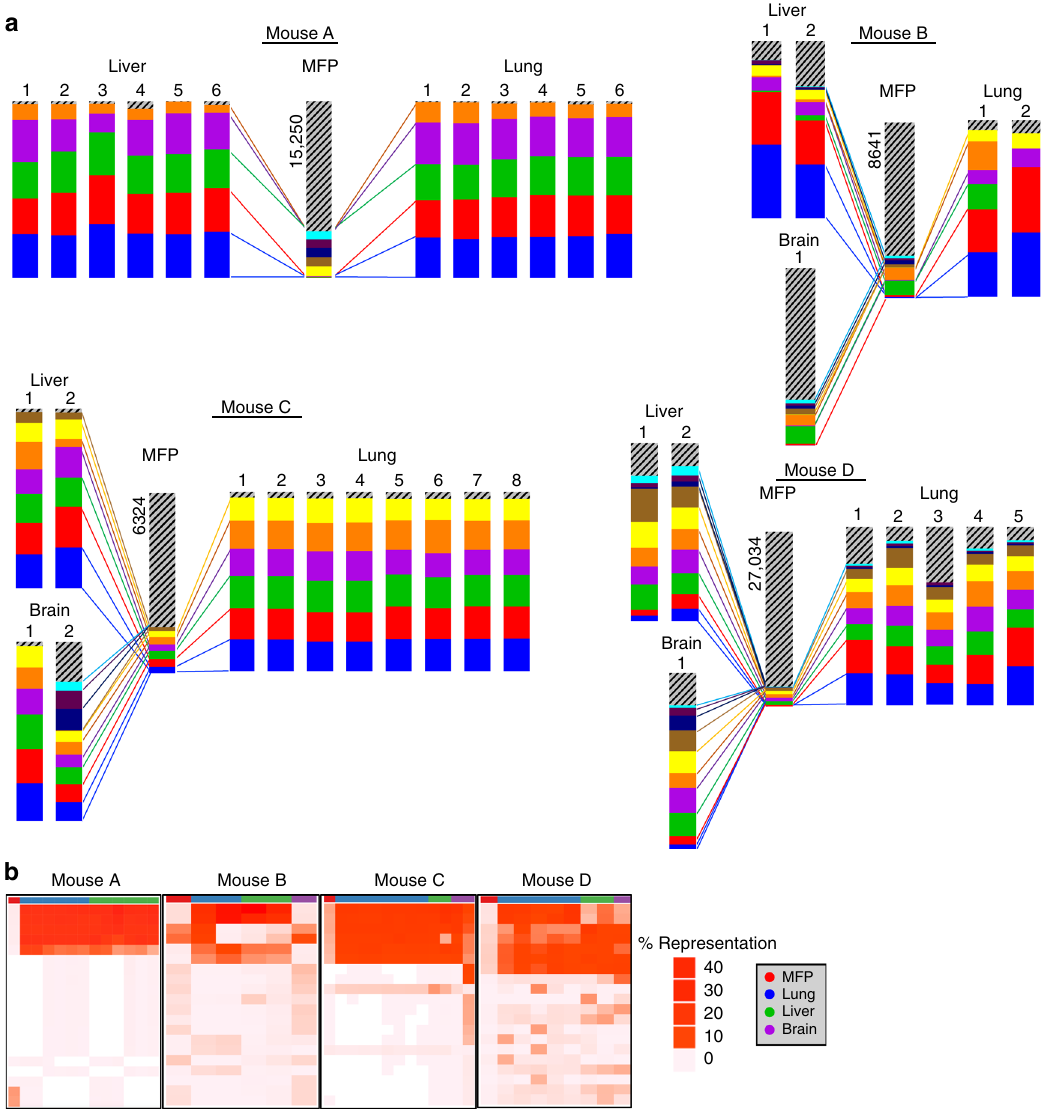
Fig. 4 Enrichment of the same barcodes in multiple metastases within each mouse. a The frequencies of the 10 most abundant barcodes detected across all samples within each mouse are plotted with different colors for each barcode. Gray striped bars represent all other barcodes in each sample comprising the remainder of the population, and the numbers of these barcodes detected in each MFP tumor is written. Barcodes marked by the same colors in different mice are not identical to one another. Colored lines indicate expansion of primary tumor clones in metastatic lesions, although cross-metastasis seeding may have also occurred. b Heat maps showing the representation of the top 20 most abundant barcodes detected across all metastatic samples in each mouse. Undetected barcodes are shown in